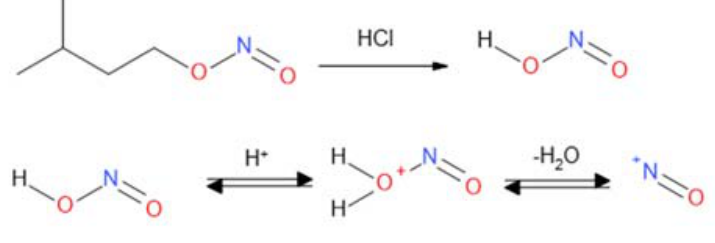
Figure 2. Generation of the nitrosonium ion.